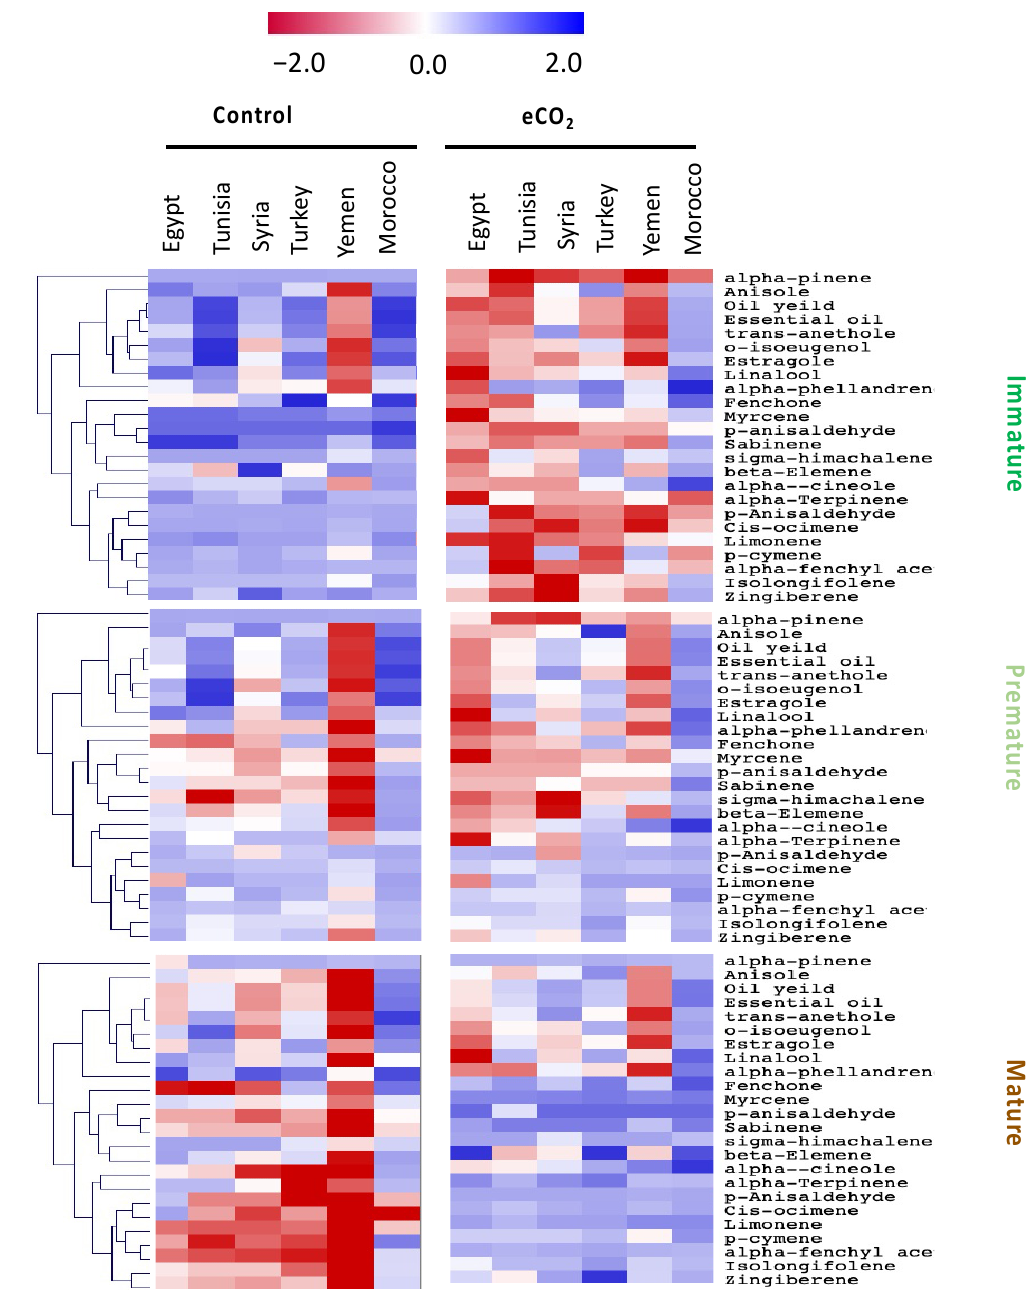
Figure 2. Heatmap showing the hierarchical clustering analysis of essential oils levels of six Pimpinella anisum L. accessions at three seed developmental stages, and under control and elevated CO 2 growth conditions. The level patterns are relatively demonstrated on the heatmap, based on the mean value ( n = 5) for each parameter. Red and blue color gradients indicate higher and lower levels, respectively.